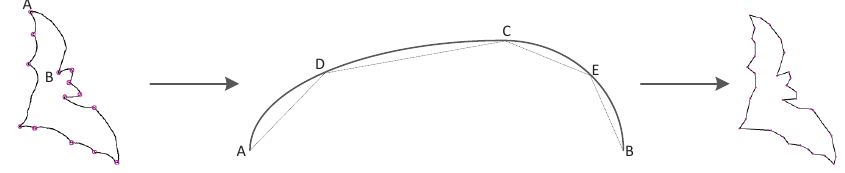
Figure 5. PSM polygon approximation with the points A, D, C, E, B.